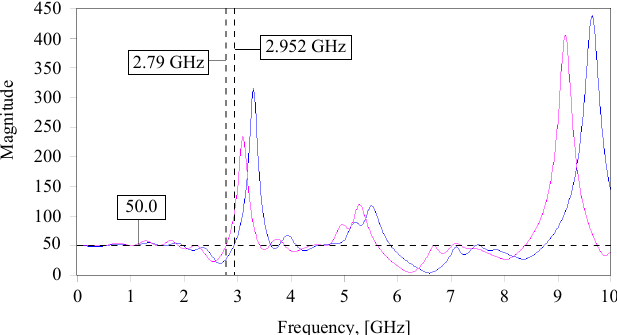
Fig. 7. The comparison of input impedance of the traditional (blue) and triangle- shaped (pink) meander lines, when Z 0 = 50 Ω . On the other hand, the stopband of the model with triangle- shape connecting conductor starts about 76 MHz earlier (Fig. 8).